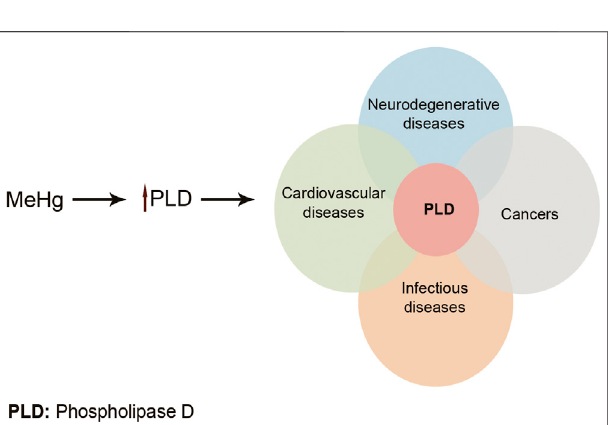
FIGURE 4 | Me-Hg induces PLD activation. Increased PLD activity can lead to many diseases and cancers. Adapted from Brown et al. (2017) .